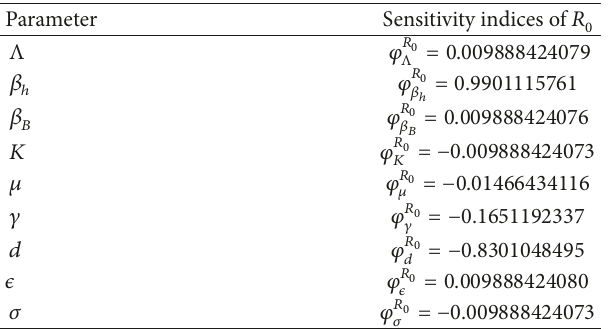
Table 4: Estimated